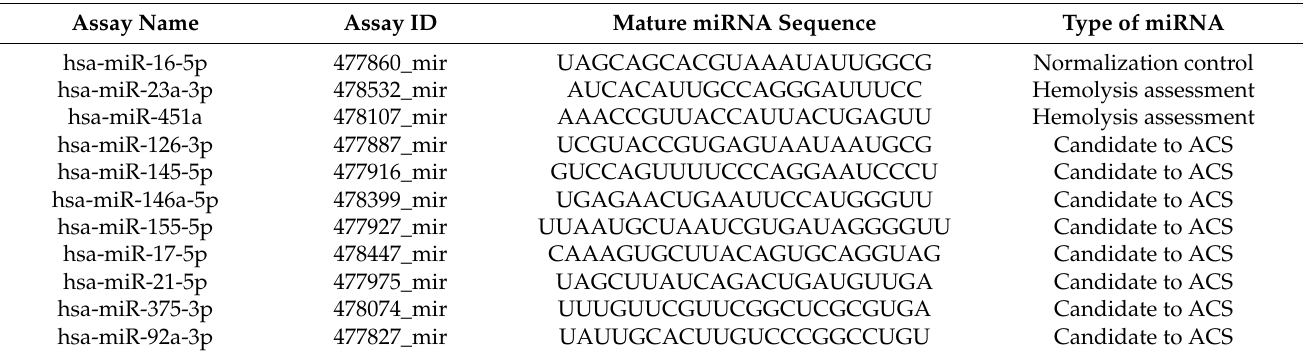
Table 1. List of the miRNA assays used for